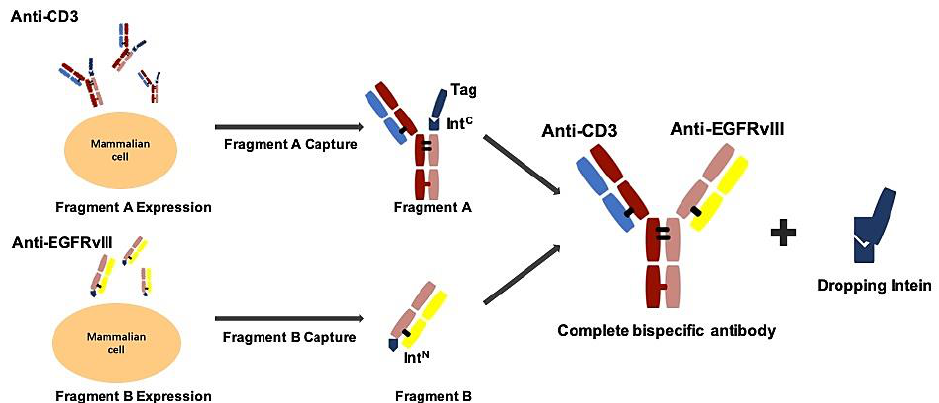
Figure 1. Schematic process of EGFRvIII-BsAb synthesis by the BAPTS platform. In this method, under 4 – 25 °C and reduced conditions, fragment A and fragment B were fused into a complete bispecific antibody, and the intein was dropped.